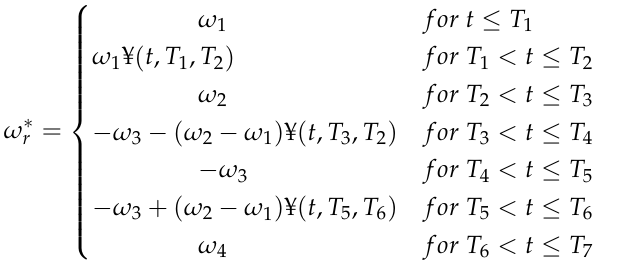
Figure 9. Load torque applied to the PMSM.